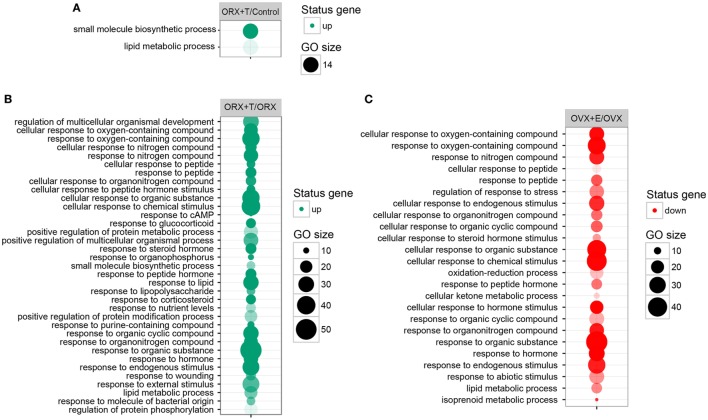
Bubble plot of overrepresented gene set in DAVID GEOTERM BP FAT annotations database obtained from comparisons of expression profiles between: (A) male control/orchiectomy (ORX) + T, (B) ORX/ORX + T, (C) ovariectomy (OVX)/OVX + E. The graphs show only the GO groups above the established cutoff criteria (p with correction <0.01, minimal number of genes per group >5). The size of each bubble reflects the number of differentially expressed genes, assigned to the GO BP terms. Transparency of the bubbles displays p value (more transparent—closer to the border of p = 0.01).